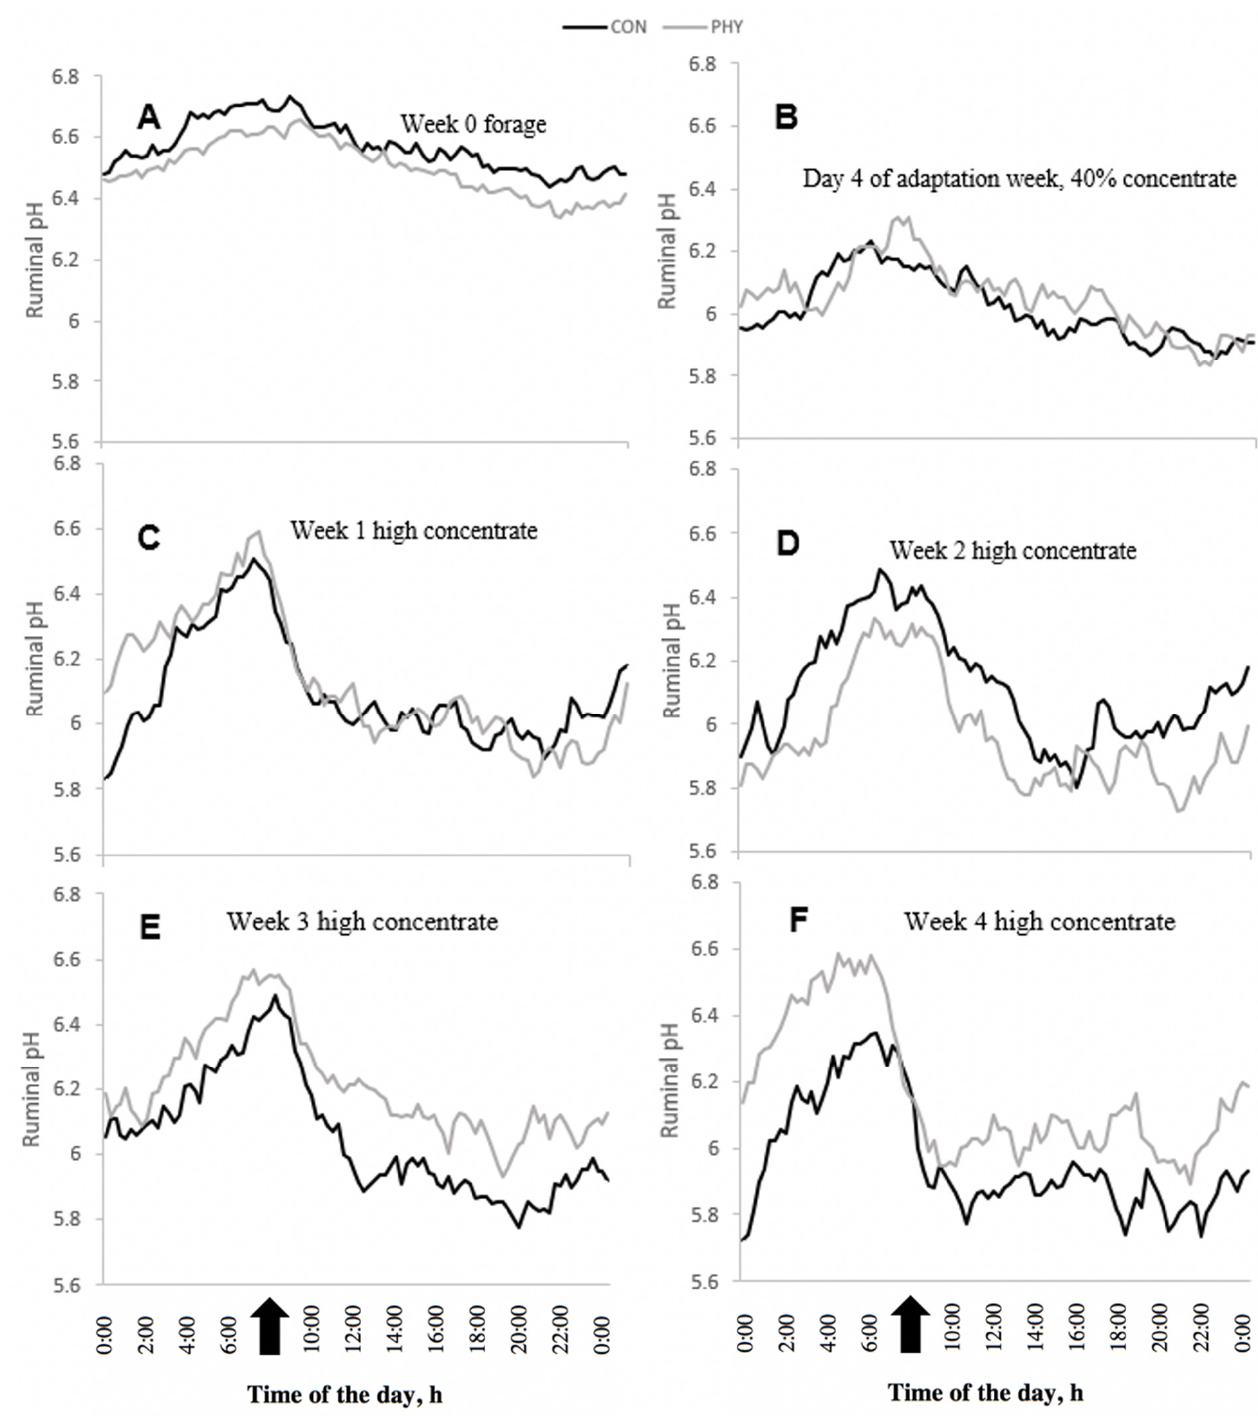
Figure 1. Diurnal variation of ruminal pH in various weeks in cows fed either forage-only or with 65% concentrate in a diet, without supplementation (CON) or supplemented (PHY) with a phytogenic